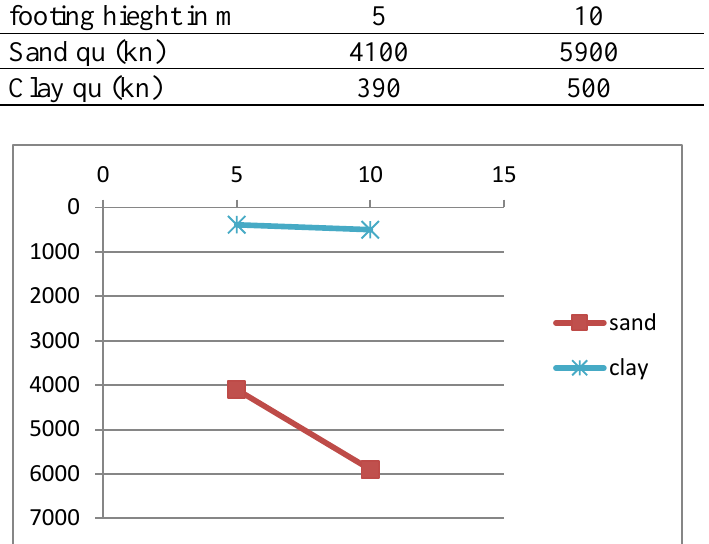
Fig. 5. Bearing Capacity height of footing